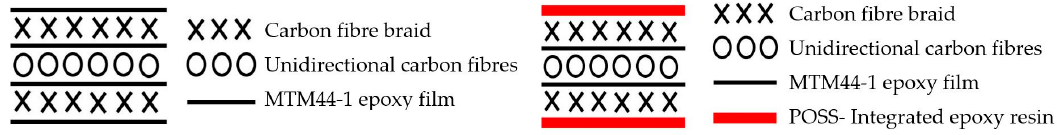
polyhedral oligomeric silsesquioxane (POSS)-integrated CY184 epoxy resin (right).